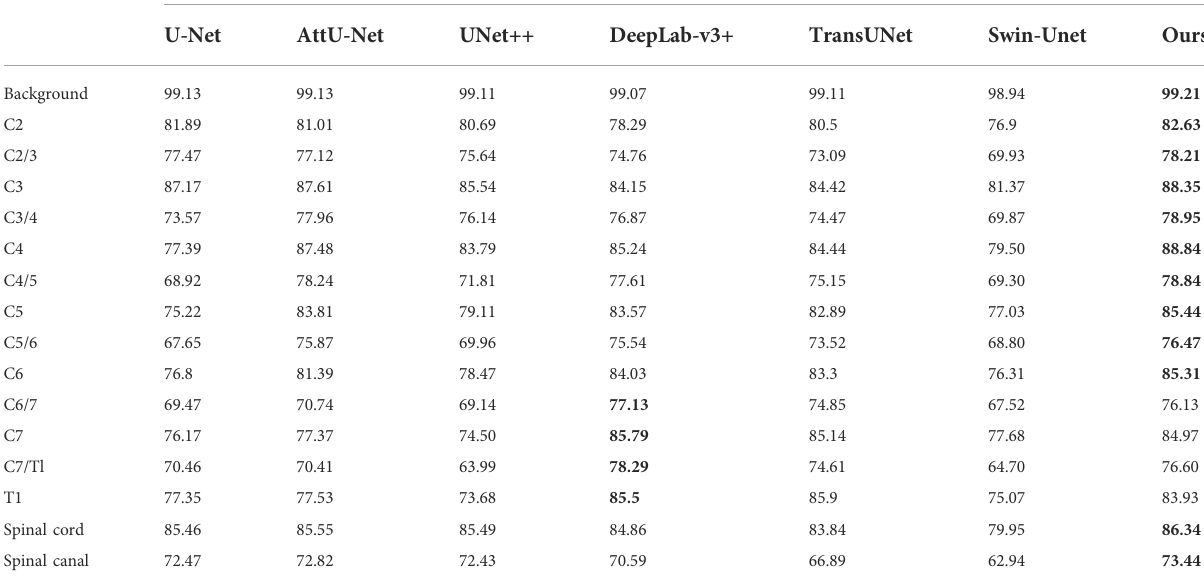
TABLE 3 Mean of the IOU for a segmented class